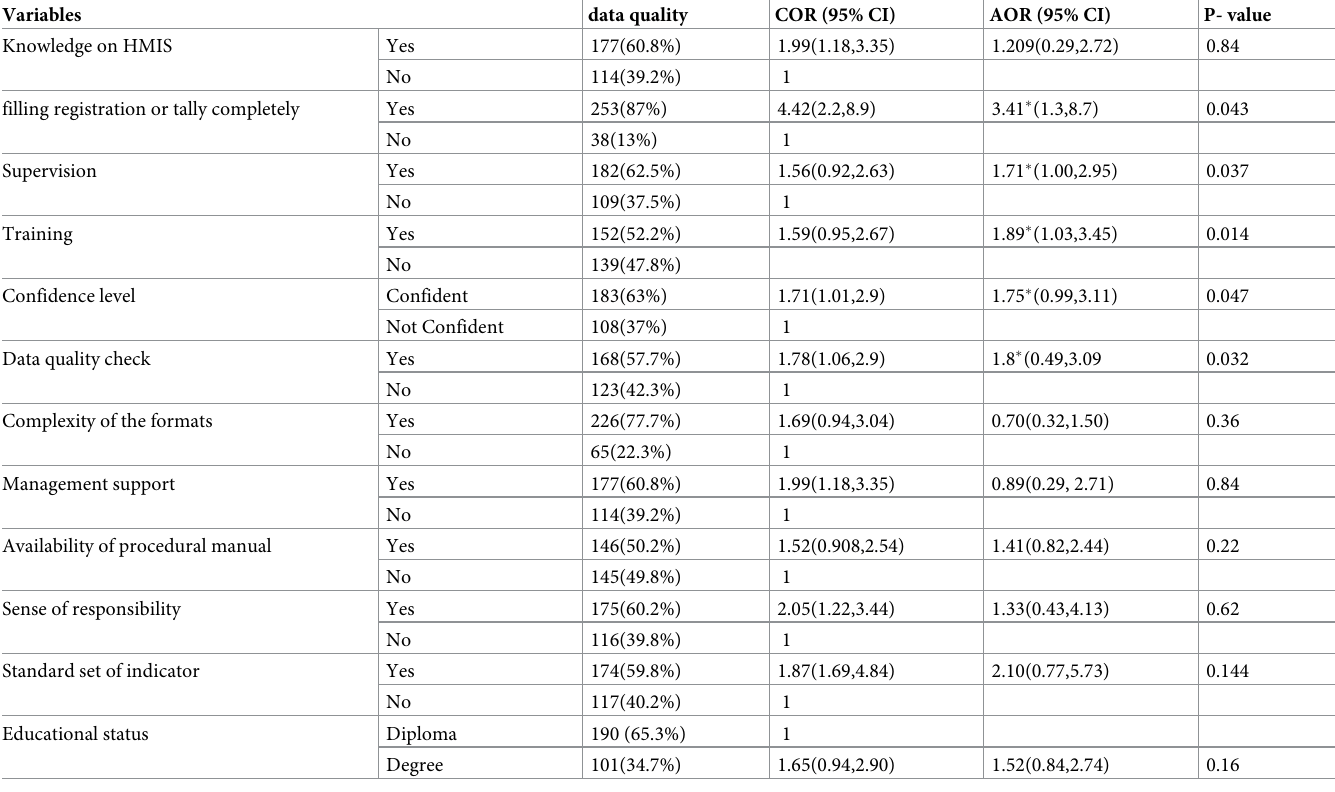
Table 4. Multi variable logistic regression result on data quality for health centers of Hadiya zone southern Ethiopia